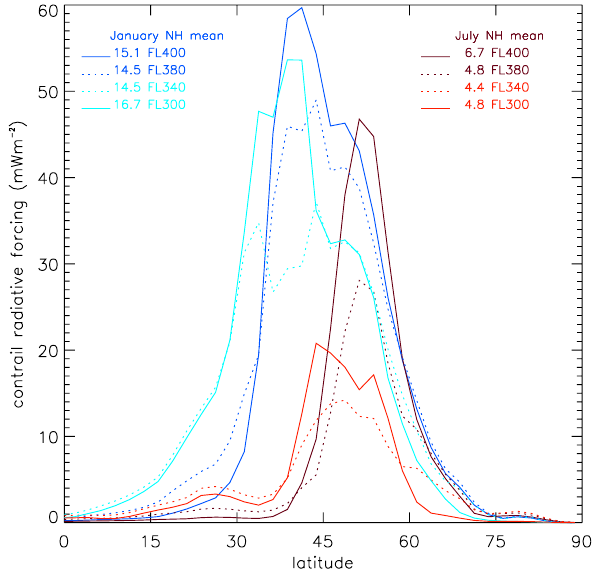
Fig. 5. January and July zonal mean contrail net RFs for cruise altitudes of 30000, 34000, 38000 and 40000 ft (FL300, FL340, FL380, and FL400 respectively). The numbers show the NH aver-